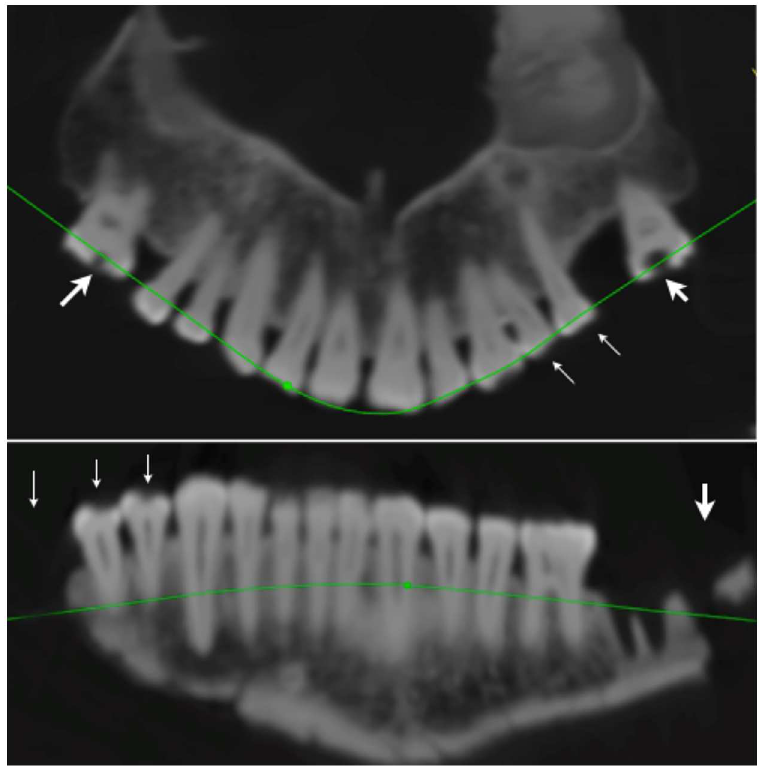
Fig 7. CT based panoramic radiograph of the maxillary (top) and mandibular dentition (bottom). Two teeth have been extracted before radiographic examination (right first and left second mandibular molar), whilethe left mandibular wisdom tooth, whose clinical crown was completelydestroyed, was not in its alveolus,and both maxillaryfirst molars have been lost intra vitam. Radiographicallyvisible deep carious lesionsare shown by large arrows; small carious lesionsthat are only visiblemacroscopically are shown by small